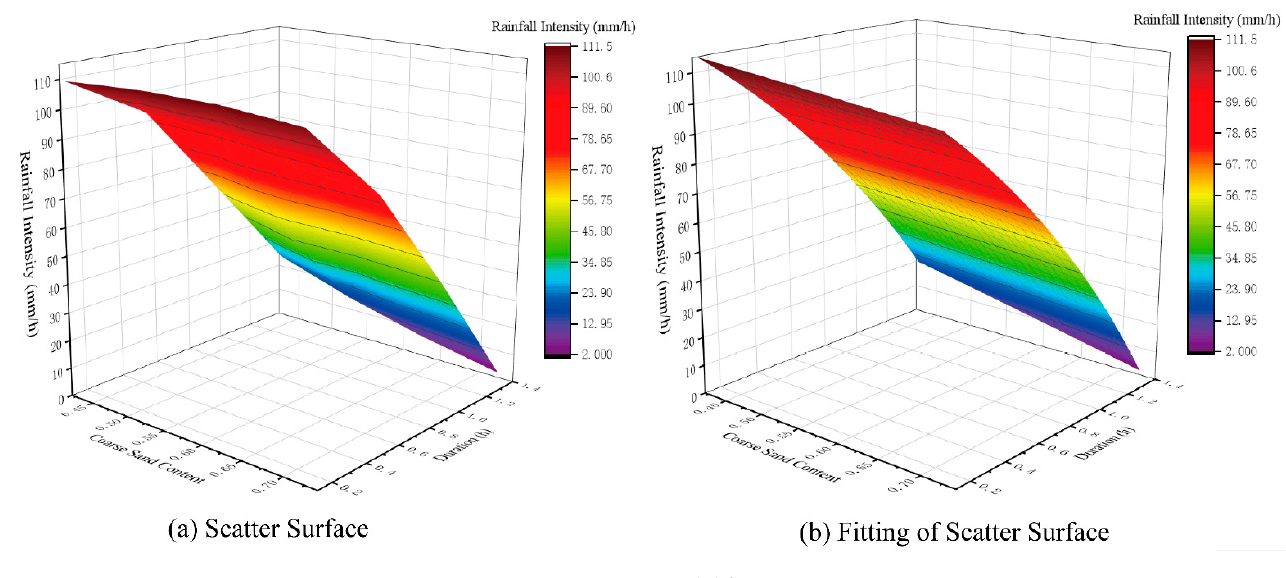
Figure 18. IPD model fitting. Figure 17. IPD model fitting.